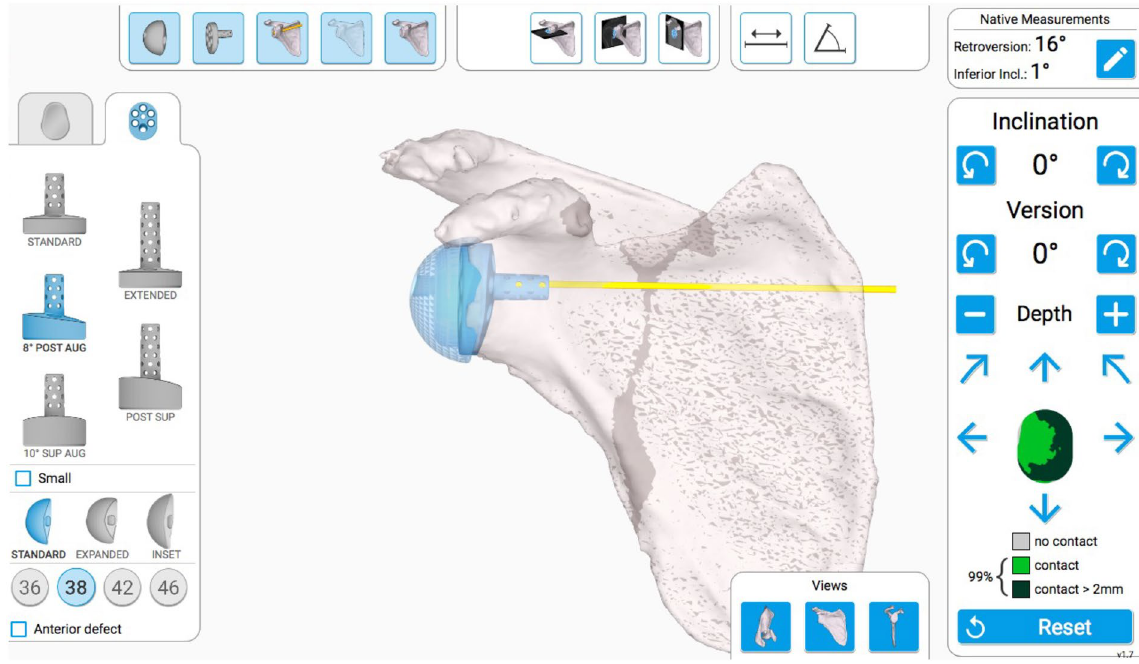
Figure 1. Pre-operative planning software of the Equinoxe Planning App. Virtual glenoid baseplate placement is used to determine the ideal component type and its position. Post posterior, Aug augmented, Sup